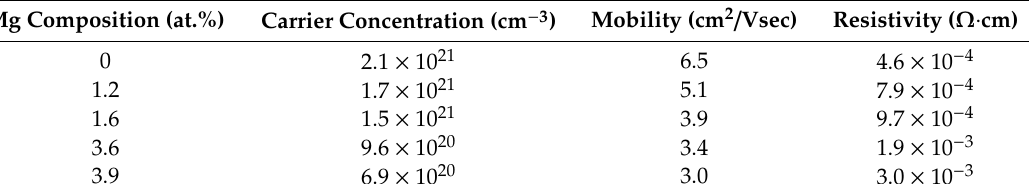
Table 2. Electrical properties of the films annealed at 600 ◦ C. Mg Composition (at.%)